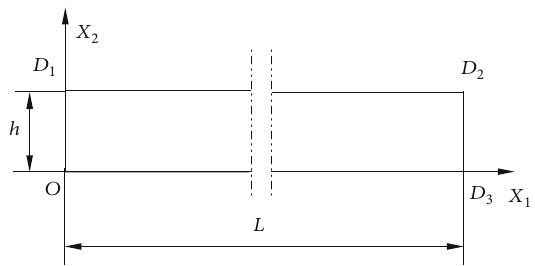
Figure 1: The computational domain of the smooth